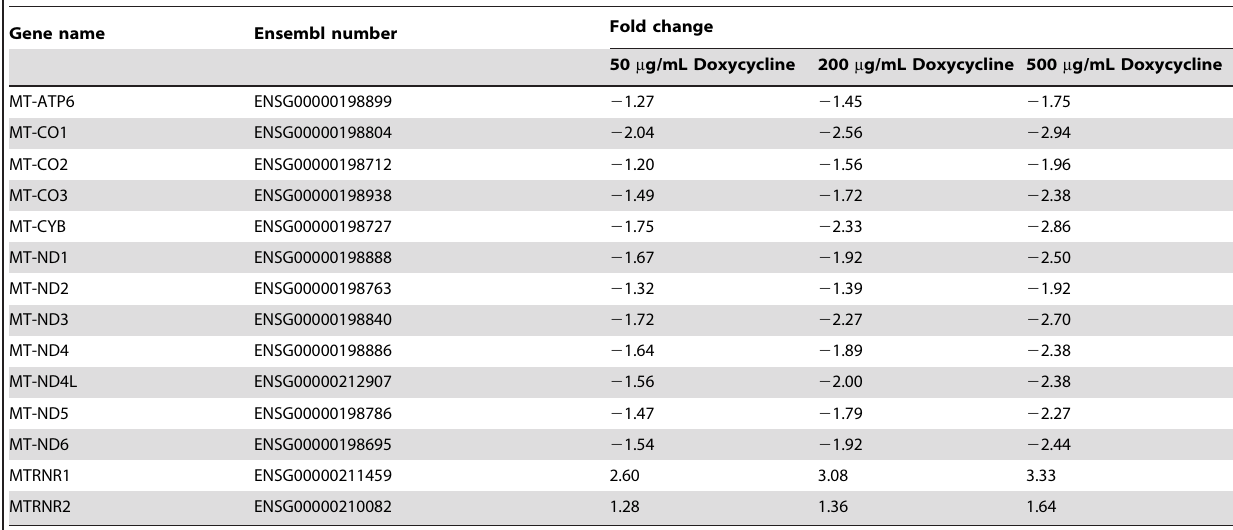
Table 1. Ultrasequencing values for mitochondrial genes.